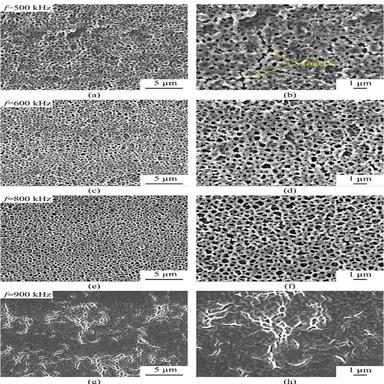
SEM morphologies of the multi-line scanned regions obtained under various repetition frequencies (P = 1.48 W, v = 10 mm/s, r = 76.6 %): (a) 500 kHz, (c) 600 kHz, (e) 800 kHz, and (g) 900 kHz. (b), (d), (f), and (h) are the local enlarged images of Fig. 4(a), (c), (e), and (g), respectively.